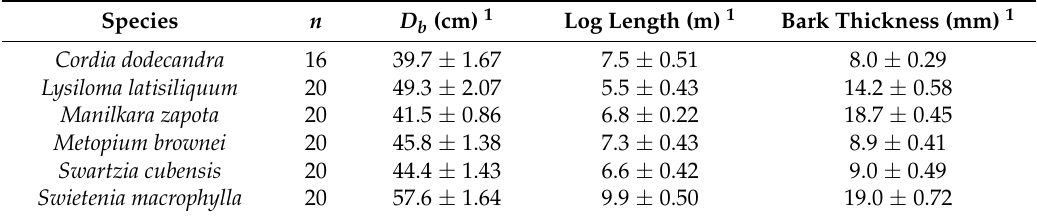
Table 2. Sample sizes and descriptive statistics per species regarding diameter at 1.3 m from the log base ( D b ), log length, and bark